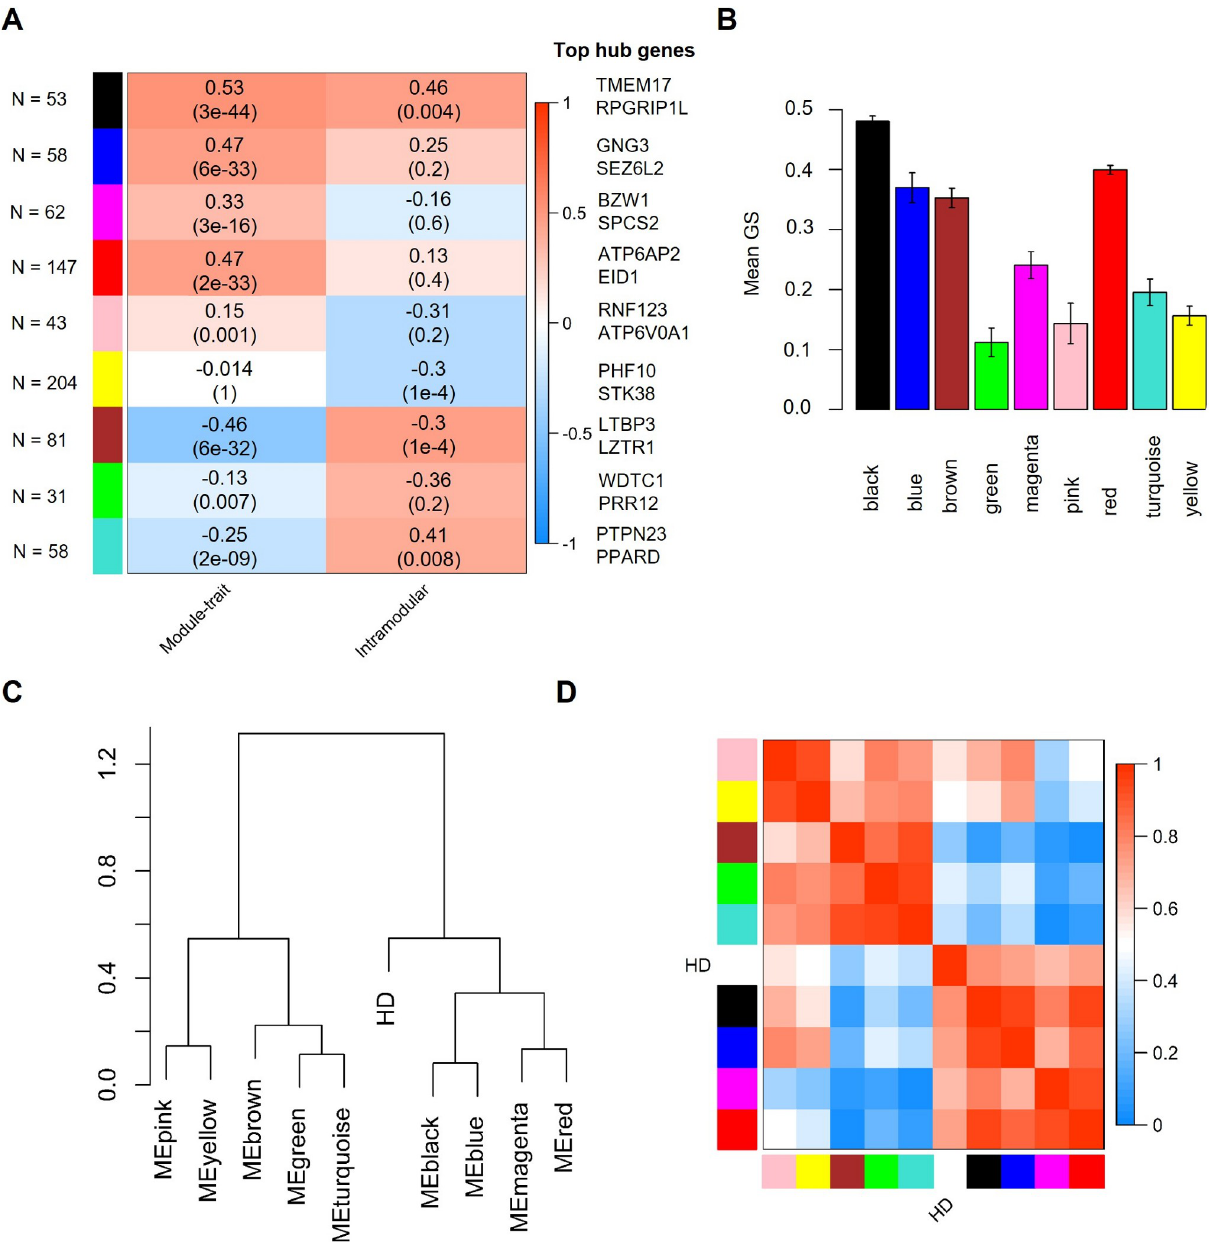
Fig 1. Result of WGCNA analysis and the association of the disease state with module eigengenes. A. Heatmap showing the correlation between module and disease state or between gene significance and module membership. A positive correlation between a module and disease state shows that the mRNA levels of genes belonging to this module were elevated in samples from HD patients and vice versa. P-values adjusted after Benjamini & Yekutieli (Yekutieli & Benjamini, 2001) are given in brackets. B: Mean gene significance of each module. Error bars depict the 95% confidence interval. C. Dendrogram showing hierarchical clustering of module eigengenes. D. Eigengene adjacency heatmap.